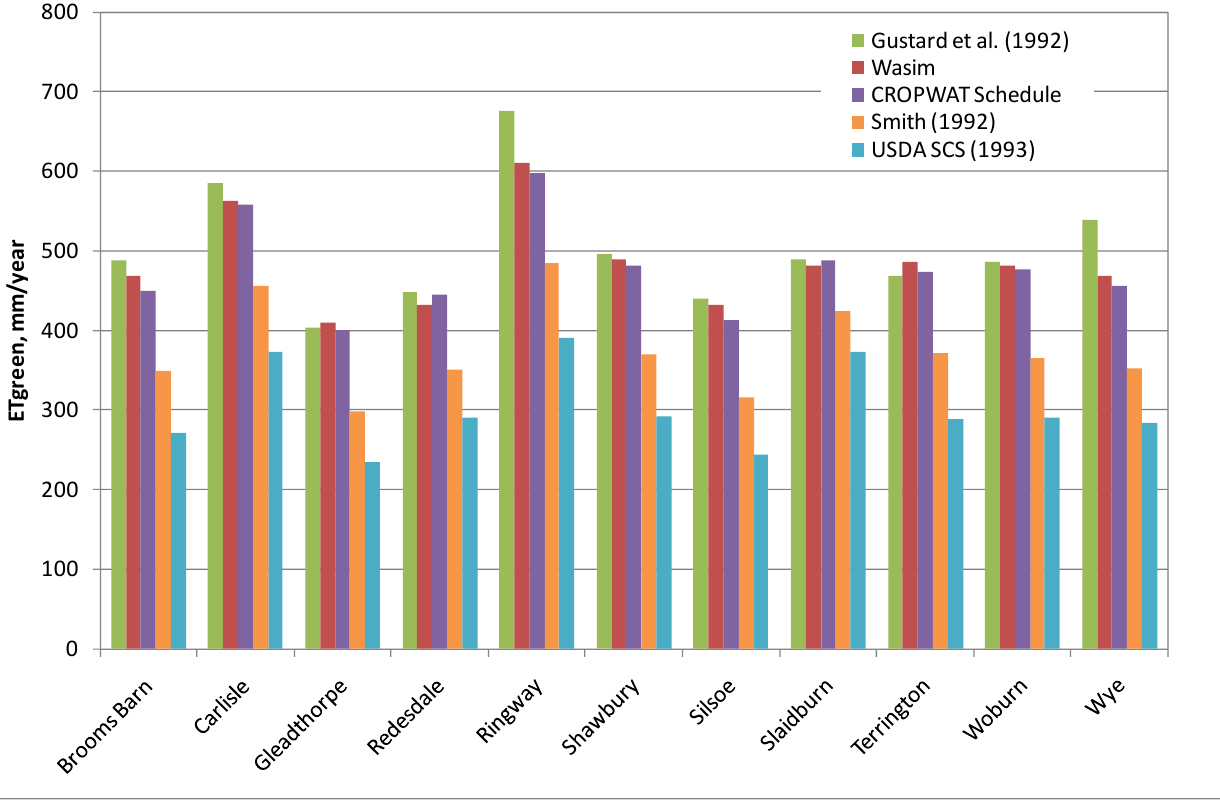
, estimated using four methods for 11 green